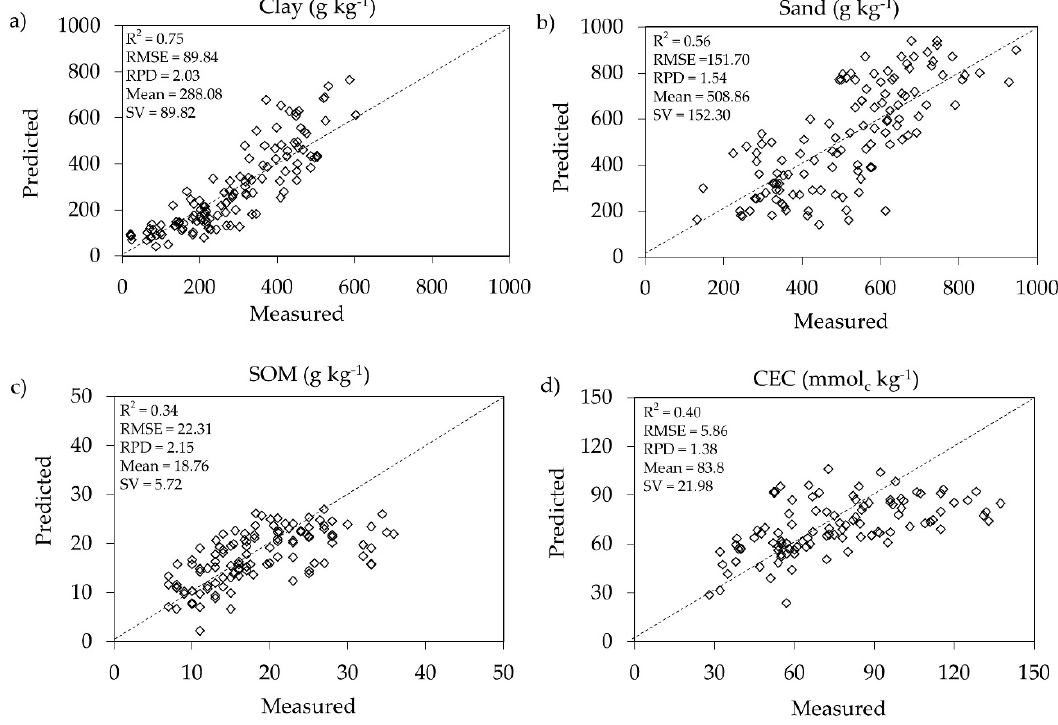
Figure 9. Measured vs. predicted soil attributes for the validation dataset of: ( a ) clay content, ( b ) sand content, ( c ) soil organic matter content and ( d ) cation exchange capacity.